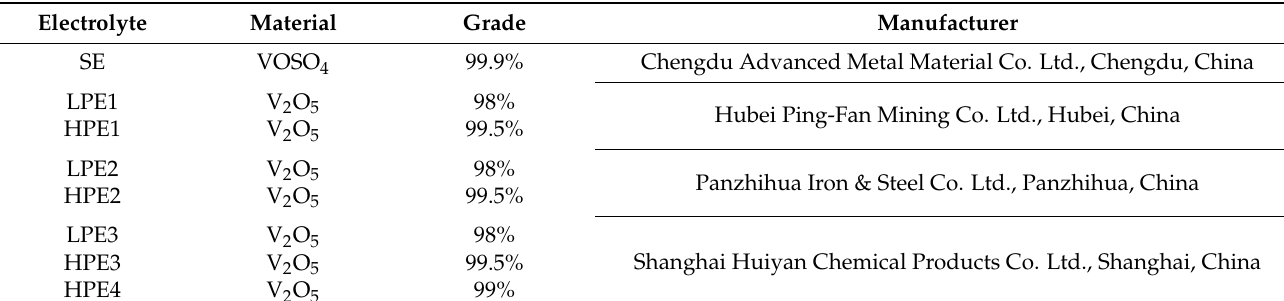
Figure 1. The process of preparing electrolytes with V 2 O 5 raw materials. Table 1. The electrolyte samples and the V 2 O 5 raw materials.